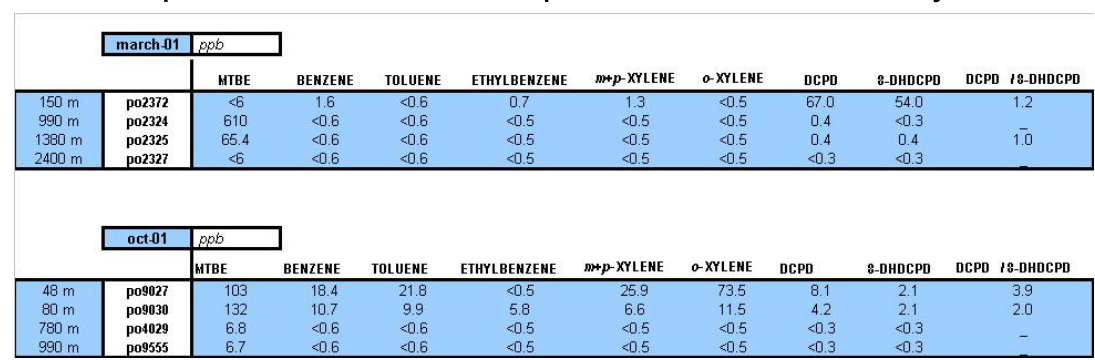
Relationship Between Distances from the Spill Focus and Contaminant Analysis Profiles